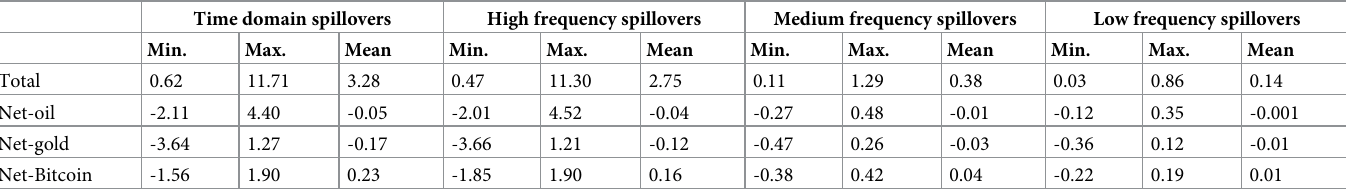
Table 3. The statistical results of time-frequency dynamics of return spillovers in crude oil, gold, and Bitcoin